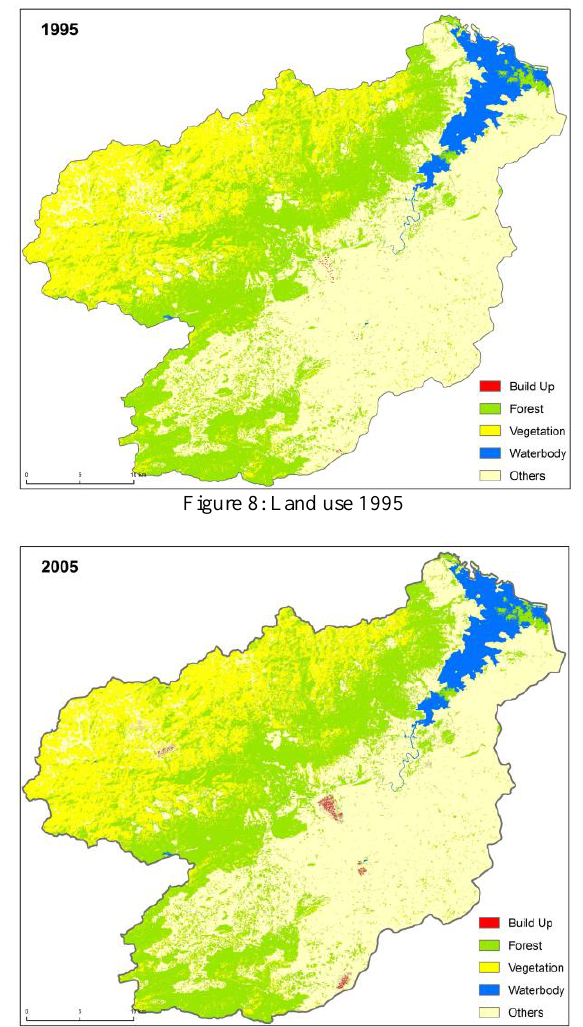
Figure 9: Land use